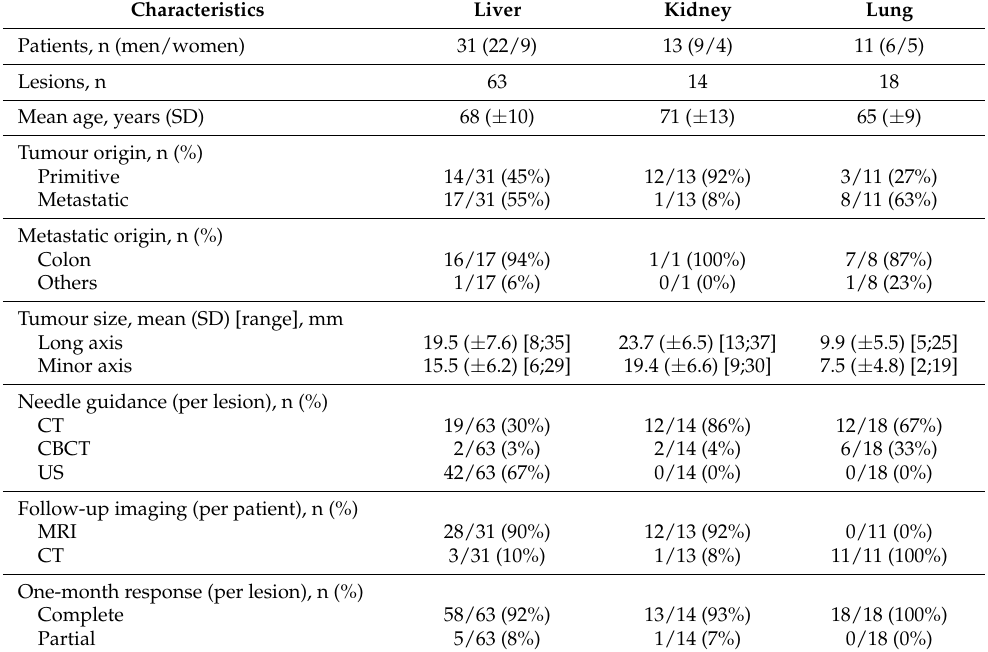
Figure 2. Examples of assessment of the ablation zones for liver ( left ), kidney ( middle ) and lung ( right ) lesions. Top : pre-treatment assessment of the target lesion (white arrows). Bottom : assessment on the one-month follow-up imaging, with the major ( L ) and minor ( l ) axes measurements. Note: air was found inside the ablation zone (tubular structure). Table 2. Patients’